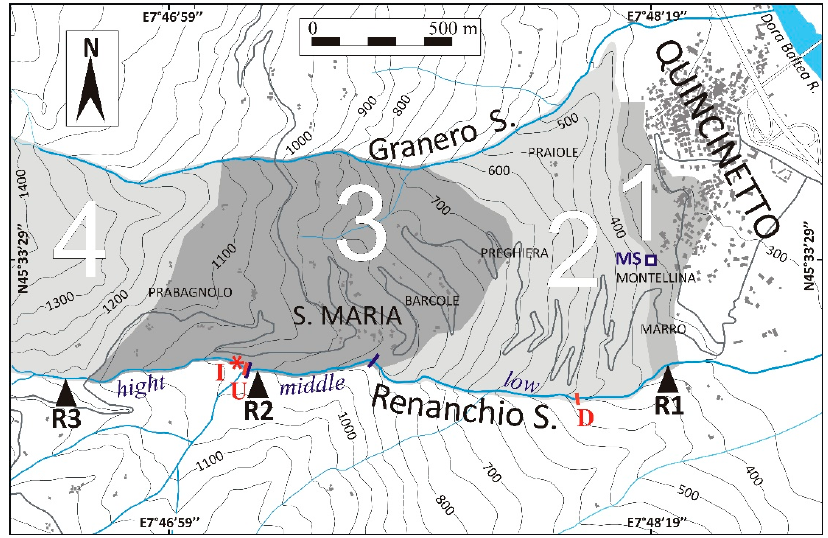
Figure 3. Location of the low, middle, and high stretches of the Renanchio Stream, reported in the text, and of the sectors of the investigated area. Sector 1 is essentially shaped in normally fissured